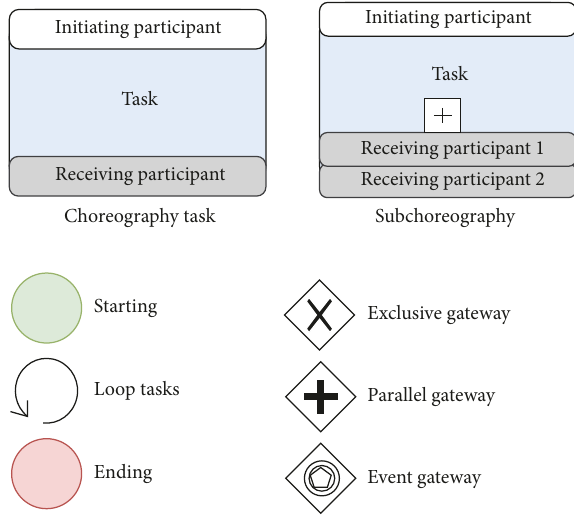
Figure 4: Main notations for choreography